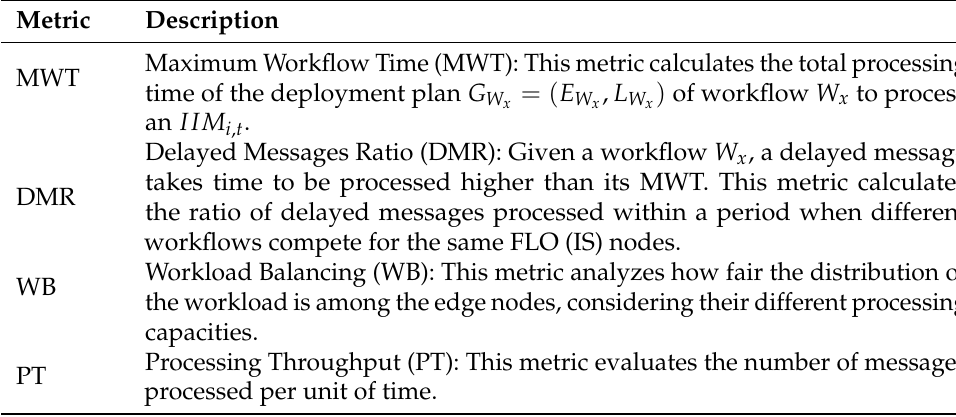
Table 2. Metrics used to evaluate the